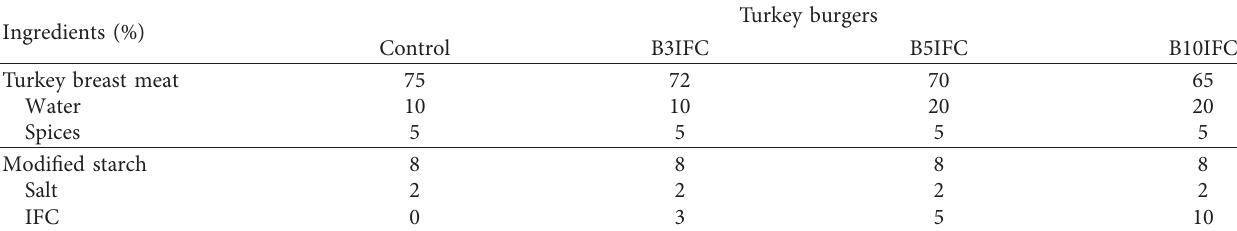
Table 1: Formulations of turkey burgers with